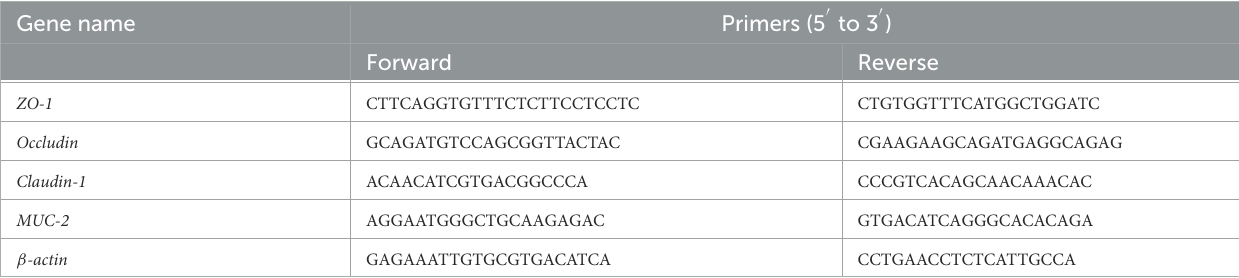
TABLE 2 Sequences of target and reference genes used for the evaluation of intestinal function.